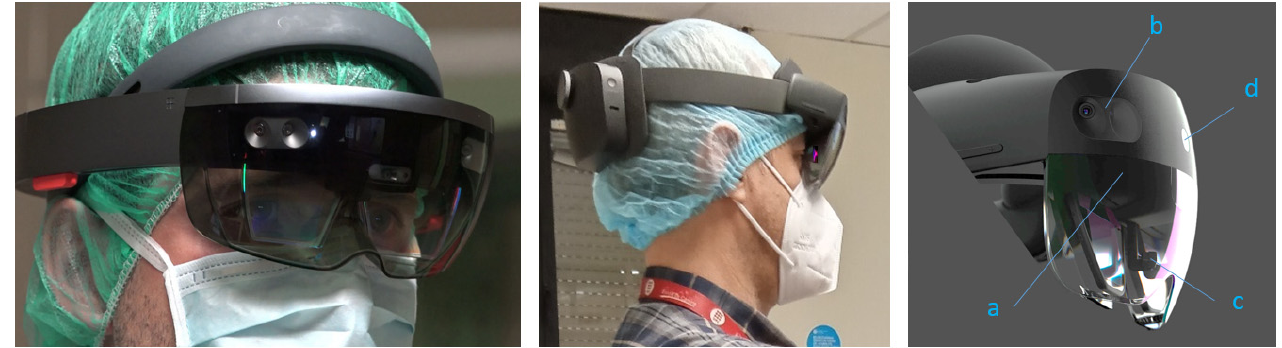
Figure 3. Microsoft’s HoloLens MR see-through holographic HMD. ( Left ) HoloLens 1. ( Center ) HoloLens 2. ( Right ) detail of some built-in sensors: (a) MEMS projector; (b) two visible-light cameras for head tracking; (c) IR camera for eye tracking; (d) depth sensor.